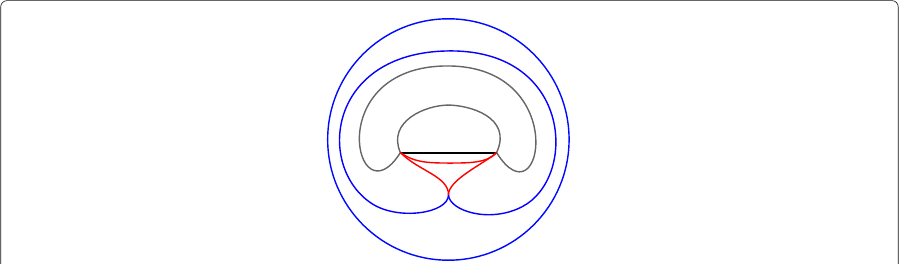
Fig. 5 Activation of a Frank-Read source: A dislocation segment (black) pinned at both ends bows out under applied stress and creates a metastable half-loop. If the shear stress acting on the source is higher than a critical value, this semi-loop expands further and rotates around the pinned ends. The recombination of loop segments (red) then generates a new complete loop (blue) and restores the original